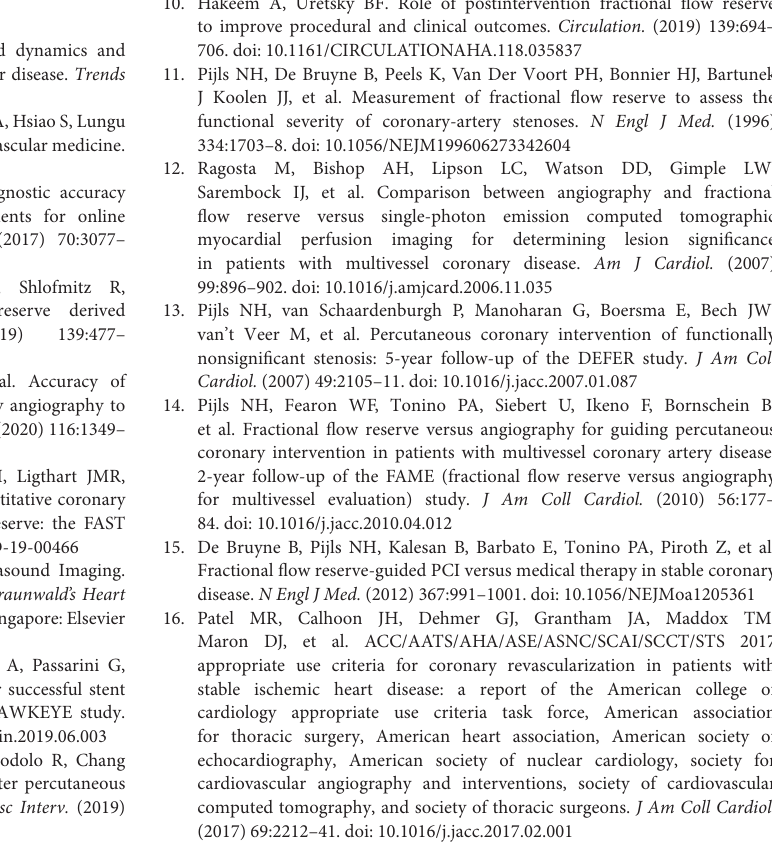
Supplementary Figure 1 | Subjects whose post-PCI wire-based FFR or caFFR values were lower than the cutoff values were categorized as the high-risk groups. LAD, left descending artery; FFR, fractional flow reserve; PCI, percutaneous coronary intervention; caFFR, coronary angiography-derived